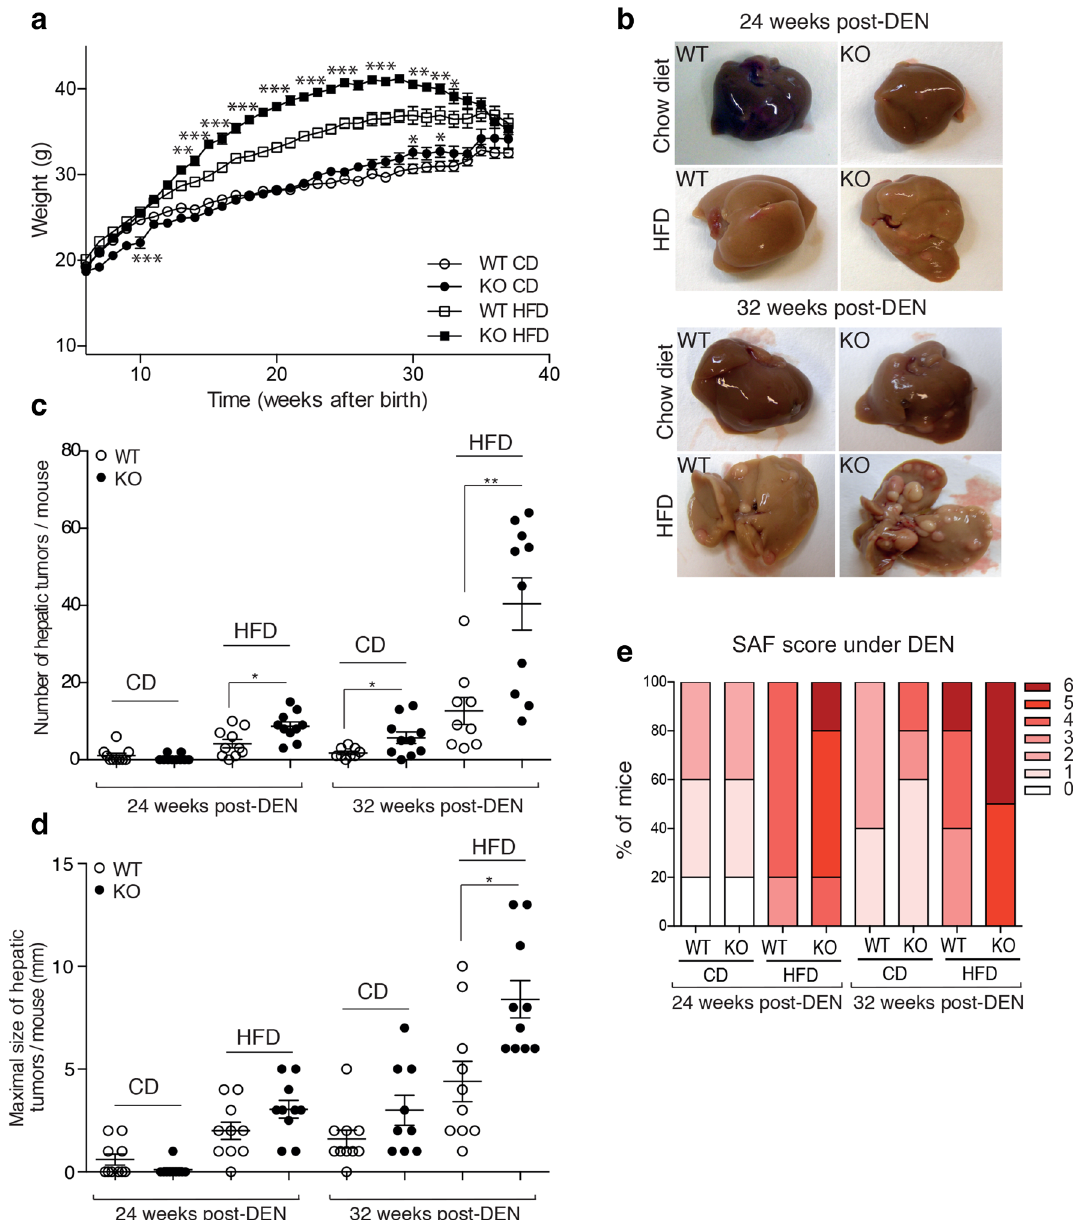
Figure 5. DUSP3 deletion associated with HFD strongly promote DEN-induced hepatocarcinogenesis. DEN (25 mg/kg) was i.p injected to 14-day-old DUSP3-KO and WT mice. Four weeks later, diet of the mice was switched to CD or HFD and weight was monitored every two weeks for 31 weeks ( a ). ( b ) Livers of WT and mutant mice kept on CD or HFD 24 and 32 weeks after the administration of DEN. ( c – e ) Tumor multiplicity ( c ), size ( d ), and SAF score evaluation ( e ) in livers of DEN-injected WT and DUSP3-KO mice kept on CD or HFD as above. Each dot represents the average number of tumors or size of the tumors for one mouse. Results are means ± SD. Each dot represents one mouse. Mean ± SD values for all mice are shown. *P < 0.05; **P < 0.01. n = 10 mice in each